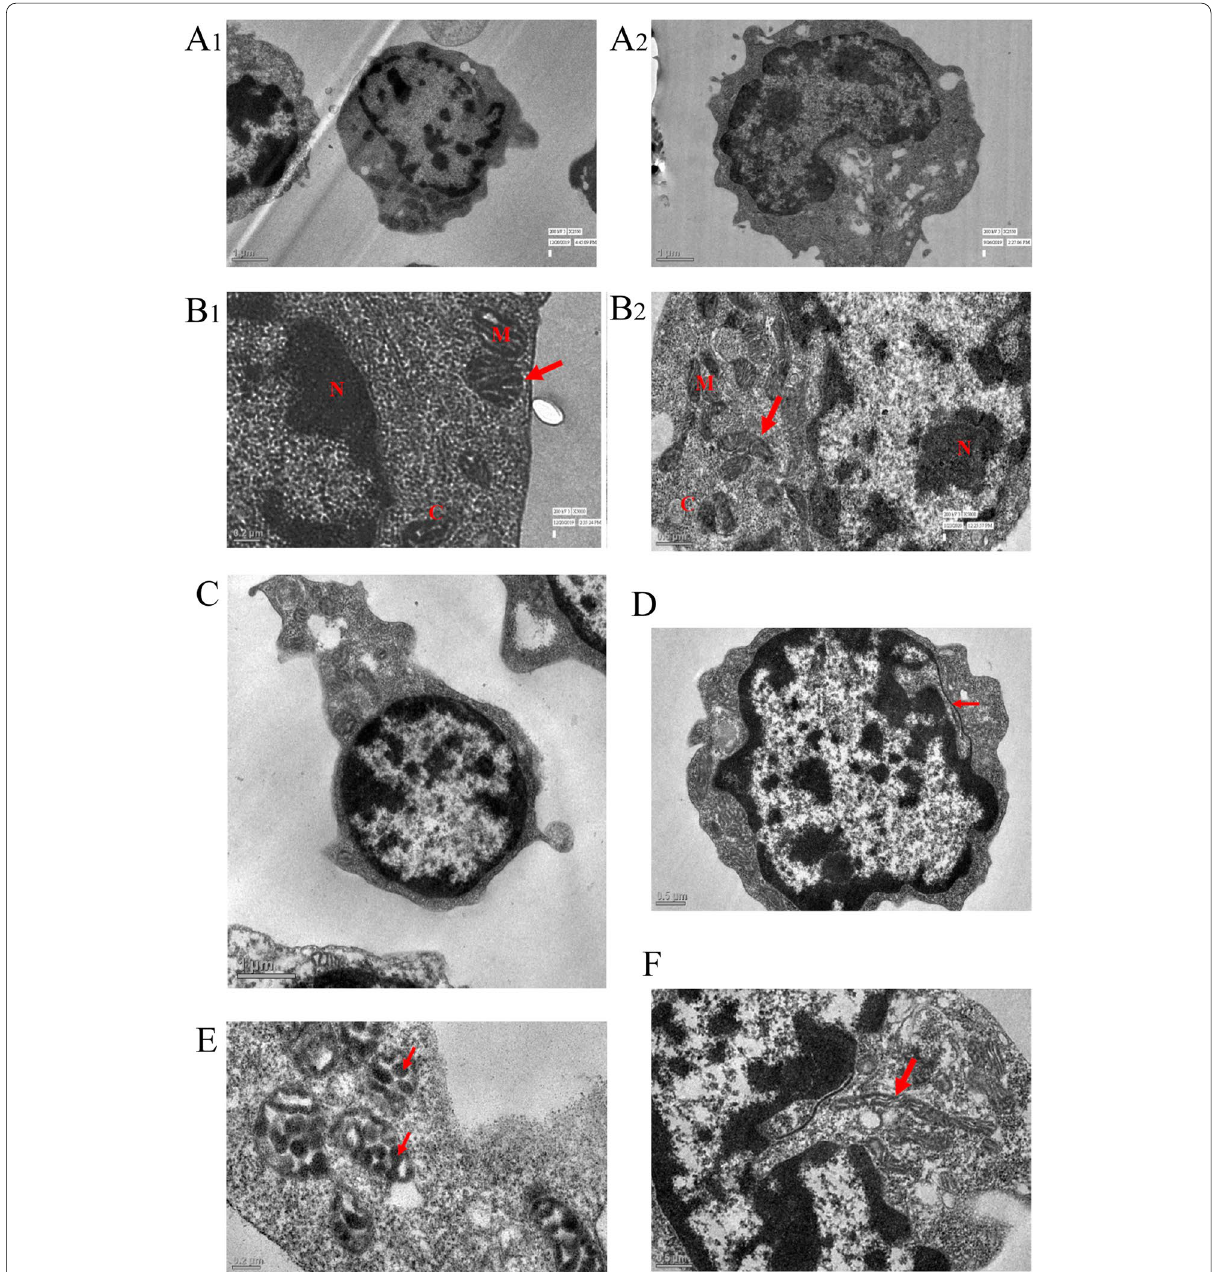
Fig. 2 A Transmission electron microscopy images of mitochondria in lymphoblast of a B-ALL patients and lymphocytes of healthy controls in A1 and A2 respectively (2250X; scale bar 1 μm). B.1 Representative electron microscopy image of mitochondria in lymphoblast of a T-ALL = patient (5000X; scale bar 0.2 μm). The mitochondria are round and globular. B.2 Representative electron microscopy image of variously shaped = mitochondria in lymphoblast of a B-ALL patient (5000X; scale bar 0.5 μm). C Representative electron microscopy image of hand-mirror shaped = lymphoblast in a B-ALL patient (2250X; scale bar 1 μm). D Representative electron microscopy image of lymphoblast showing nuclear pockets in a = B-ALL patient (4000X; scale bar 0.5 μm). E Representative electron microscopy image of lymphoblast showing vesicular cristae in mitochondria of = a T-ALL patient; each arrow depicting cristae in mitochondria (9900X; scale bar 2 μm). F Representative electron microscopy image of lymphoblast = in which the arrow is showing abnormally elongated mitochondria in a B-ALL patient (4000X; scale bar 0.5 μm). N nucleus; C cytoplasm and = = = M =